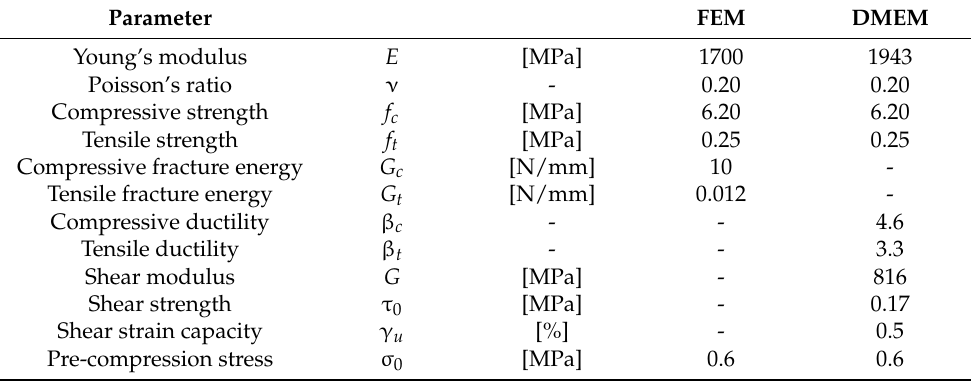
Table 1. Mechanical properties of masonry used in the DIANA FEM and 3DMacro